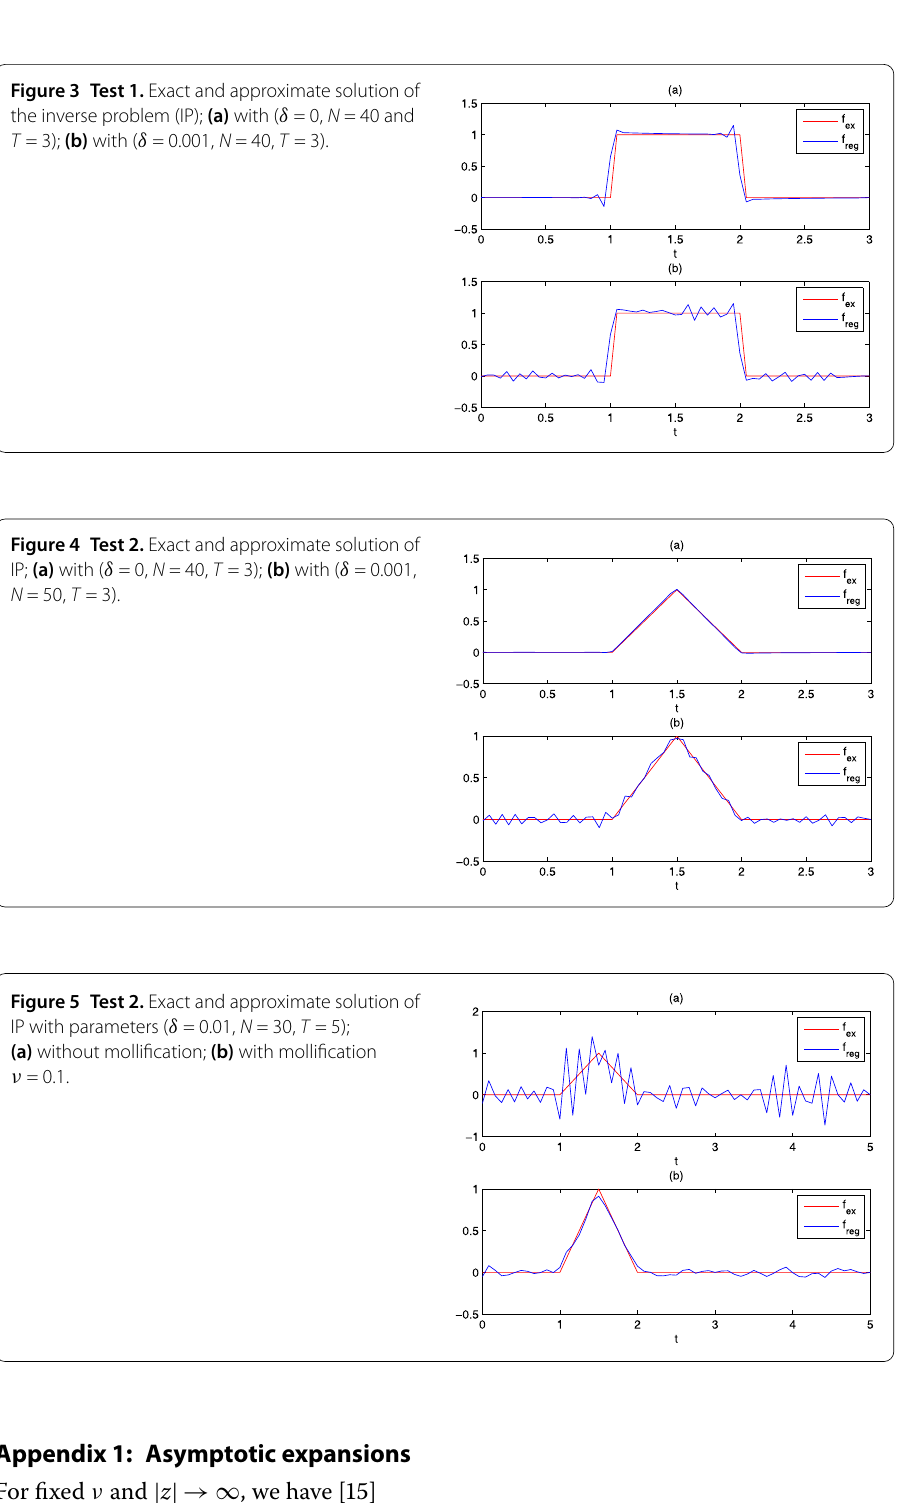
Figure 3 Test 1. Exact and approximate solution of the inverse problem (IP); (a) with ( δ = 0, N = 40 and T = 3); (b) with ( δ = 0.001, N = 40, T = 3).